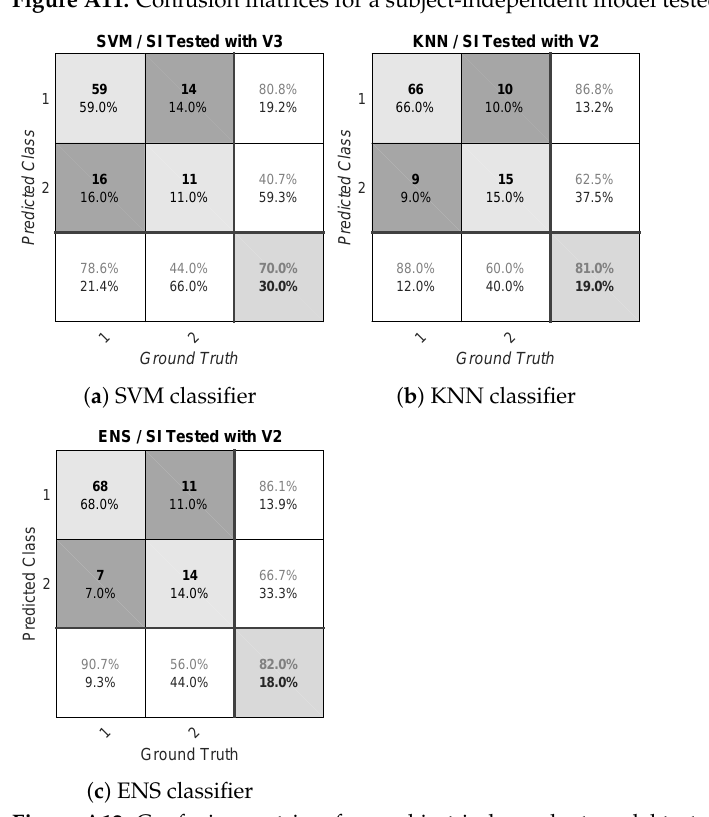
Figure A12. Confusion matrices for a subject-independent model tested with